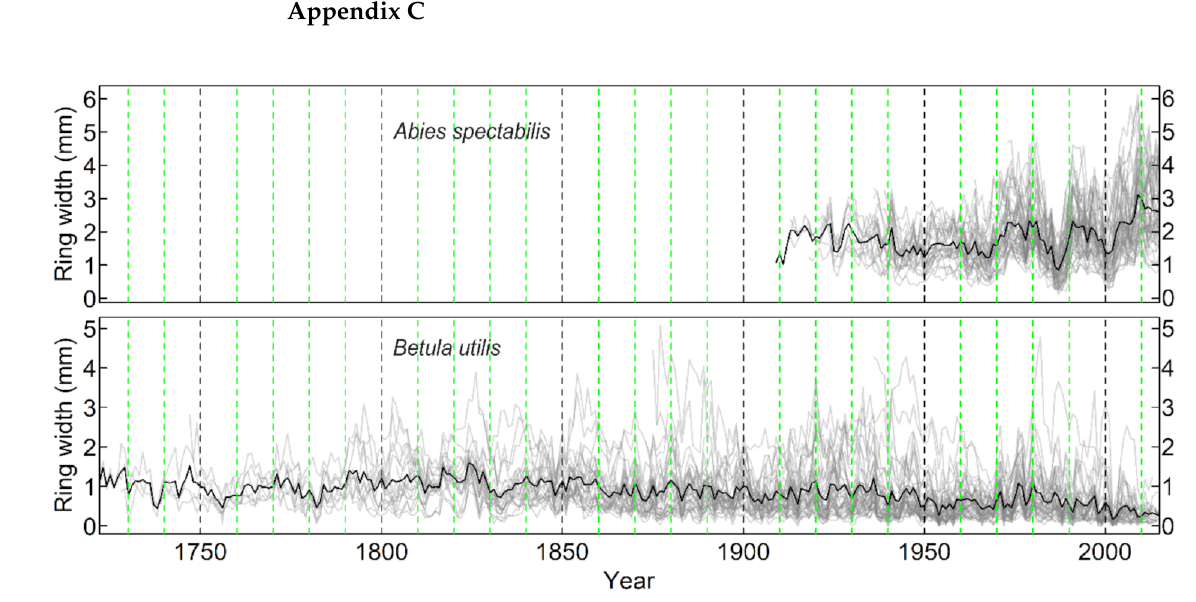
Figure A2. Raw ring width overview of Abies spectabilis (upper) and Betula utilis (lower). Grey lines are individual ring width series, black bold lines are mean of all the series.